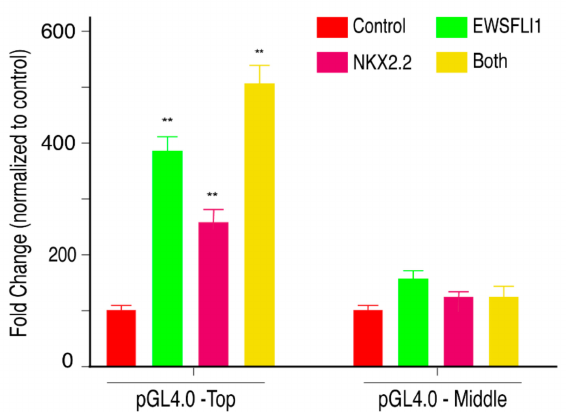
Figure 7. NKX2.2 works co-operatively with EWSFLI1 to regulate STEAP1: HEK293T cells were transfected with an empty vector, or plasmids expressing EWSFLI1, or NKX2.2, or both EWSFLI1 and NKX2.2 expressing plasmids followed by transfection with the pGL4 luciferase plasmid containing STEAP1 promoter regions. pGL4.0-Top contains the top region of STEAP1 promoter that has binding sites for both EWSFLI1 and NKX2.2 while the pGL4.0-Middle contains the middle region of the STEAP1 promoter that does not have any binding site for EWSFLI1 or NKX2.2. Quantification of signal obtained when luciferase substrate was added to the supernatant of lysed cells after normalizing to transfection control. The results were obtained as percent fold change by normalizing the control to 100%. Error bars indicate 95% confidence interval of 3 independent experiments done in triplicates. ** p <